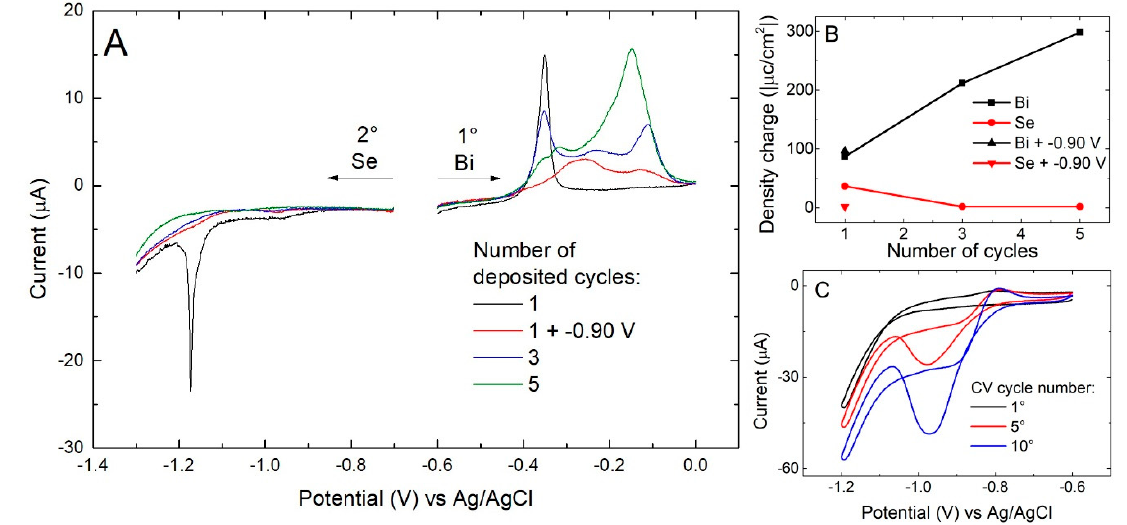
Figure 4. ( A ) Stripping of the Se/Bi n , with n equal to the number of the cycles performed (from 1 to 5), first removing the metal and then the non-metal element, 10 mV/s scan rate; ( B ) charge calculated integrating the stripping curves; ( C ) consecutive CVs cycles of selenite on bulk Bi: 1st black, 5th red, 10th blue, 50 mV/s scan rate.